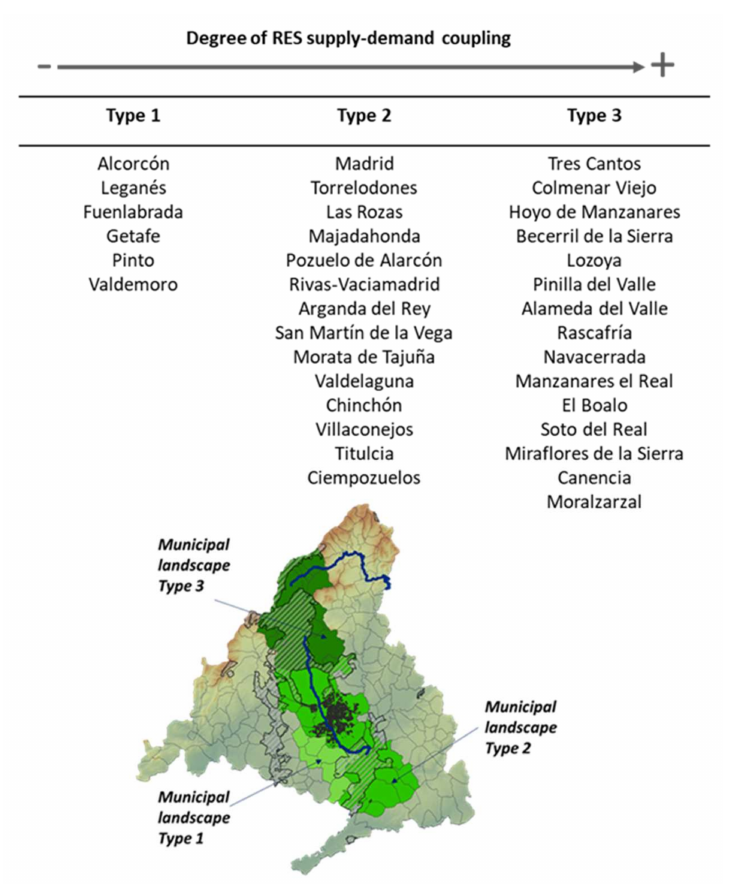
Figure A1. Types of municipalities according to the coupling between supply and demand of RES and their geographical location along the rural-urban